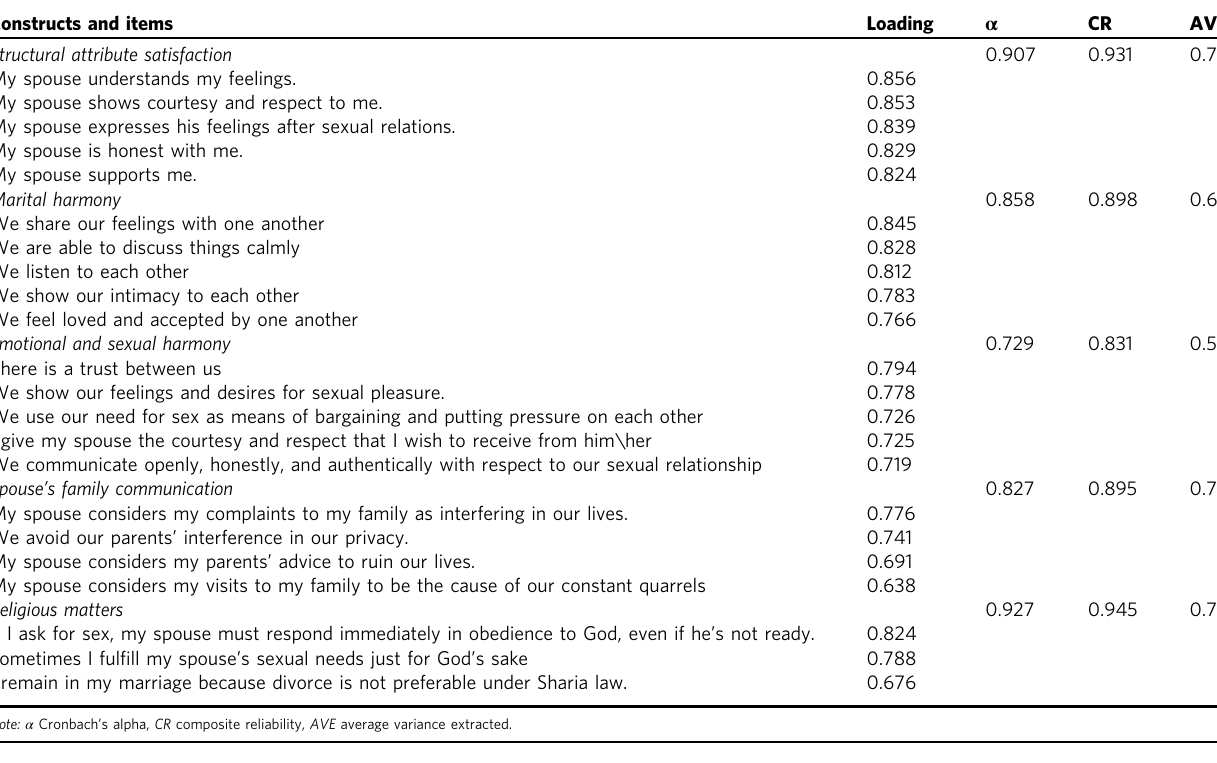
Table 4 Assessment results of the measurement model. Constructs and items